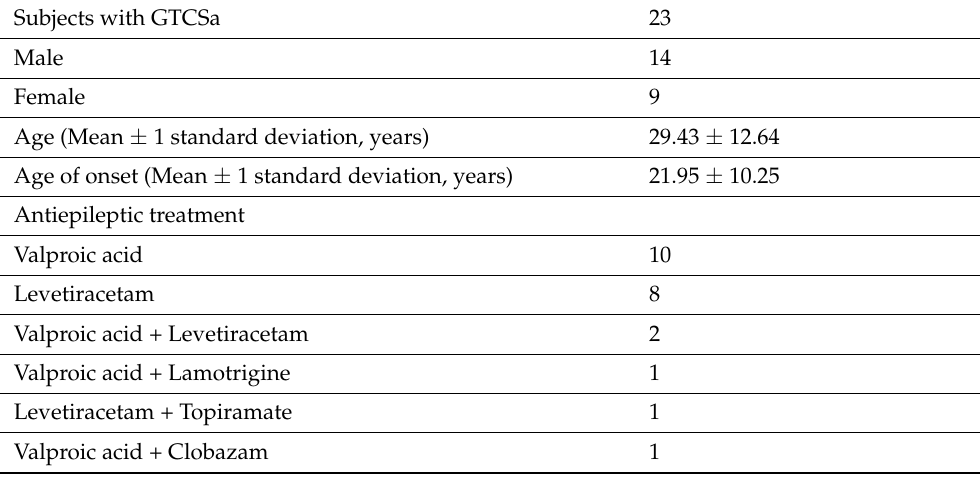
Table 1. Patient